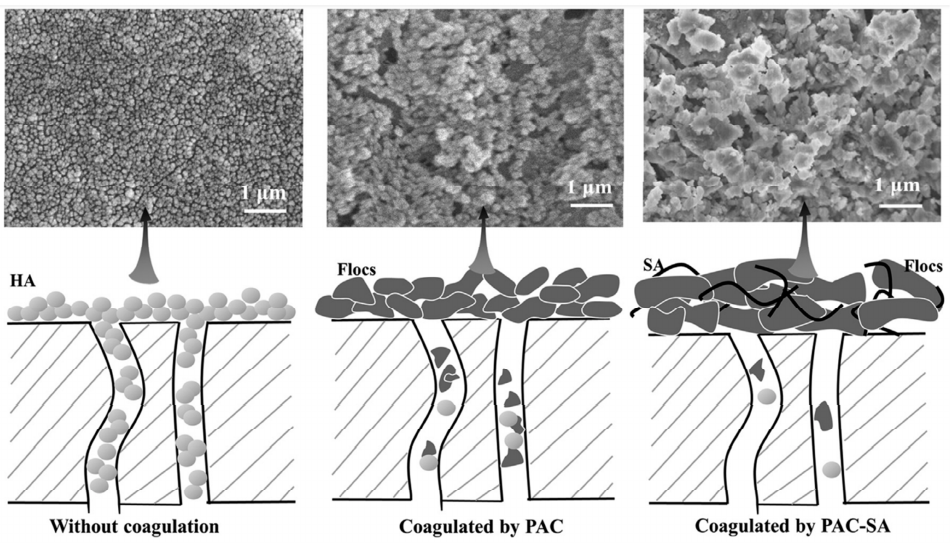
Figure 3. Cake layer morphology and fouling mechanism of UF membrane under different pretreat- ment conditions [13].